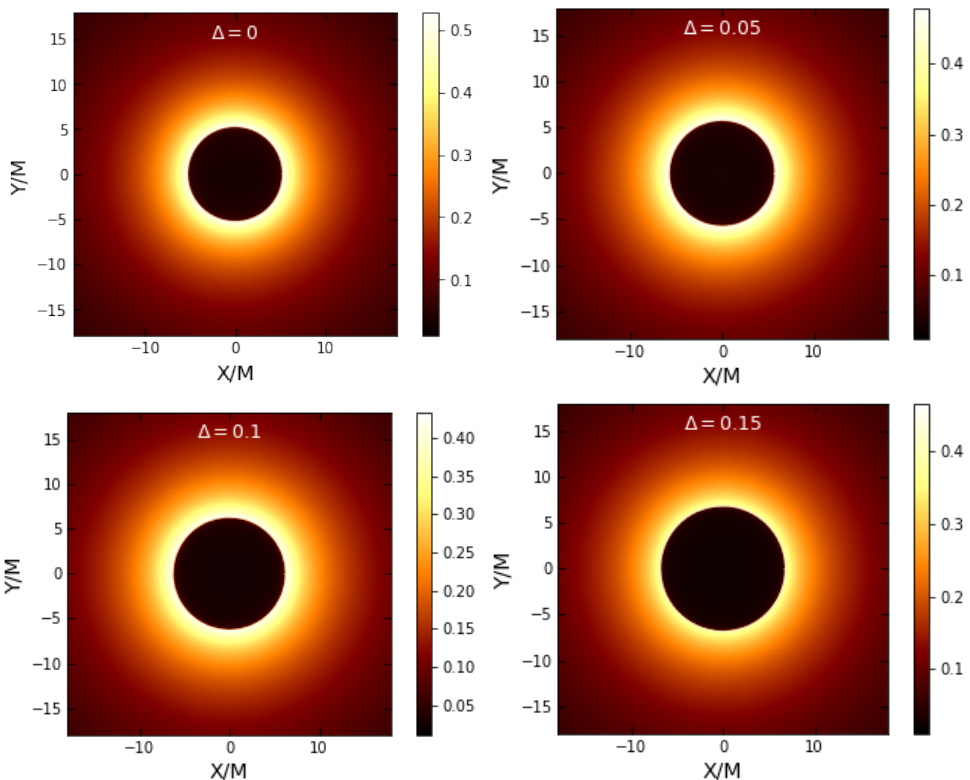
Figure 1. The shadow images and intensities for various values of Barrow exponent ∆ , for fixed M =